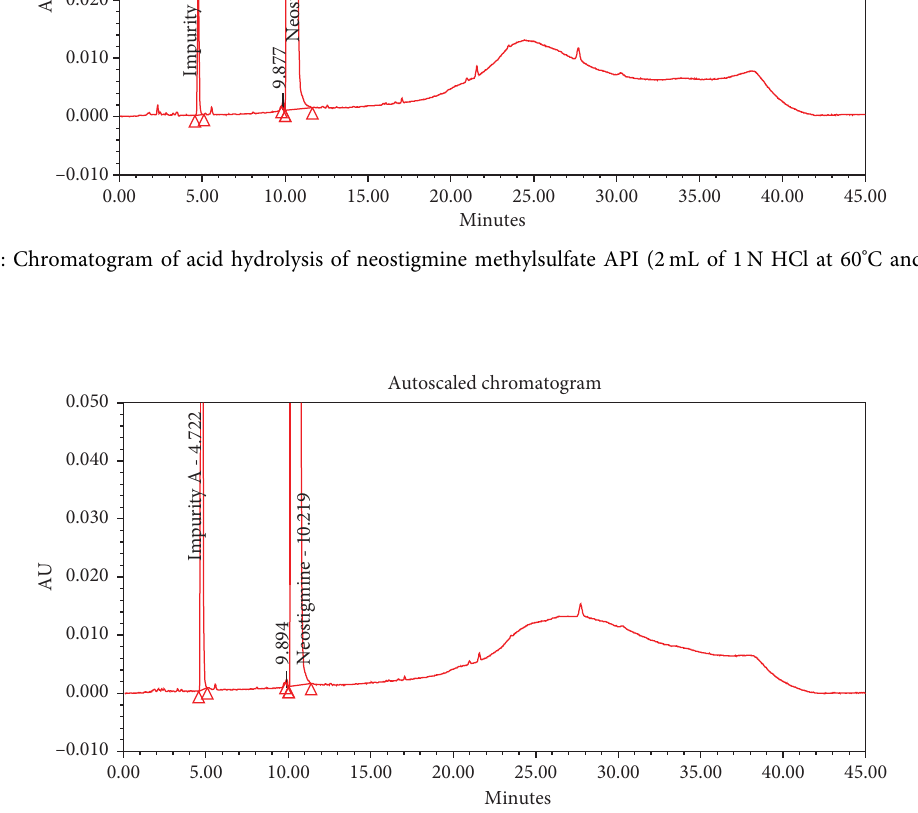
Figure 7: Chromatogram of alkali hydrolysis of neostigmine methylsulfate API (1mL of 0.1 N NaOH,